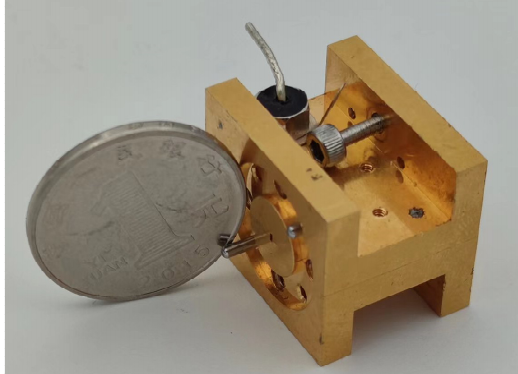
Figure 16. The picture of 220 GHz frequency tripler.